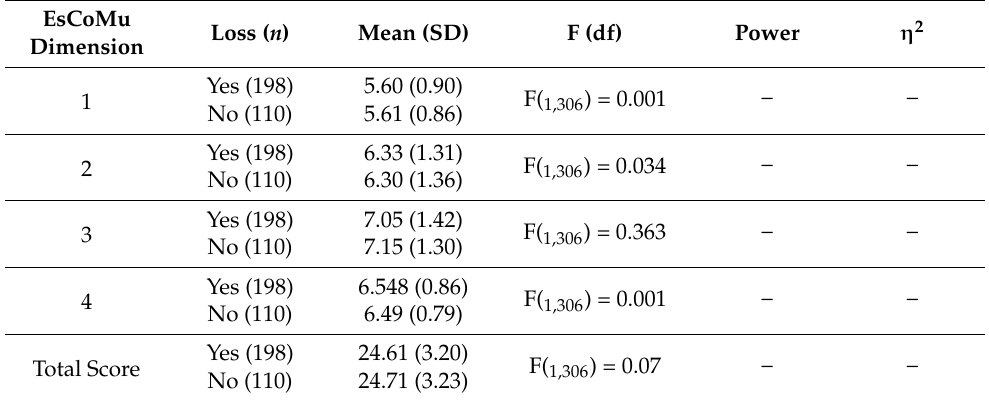
Table 8. MANOVA results for recent loss with EsCoMu dimensions and total scores.